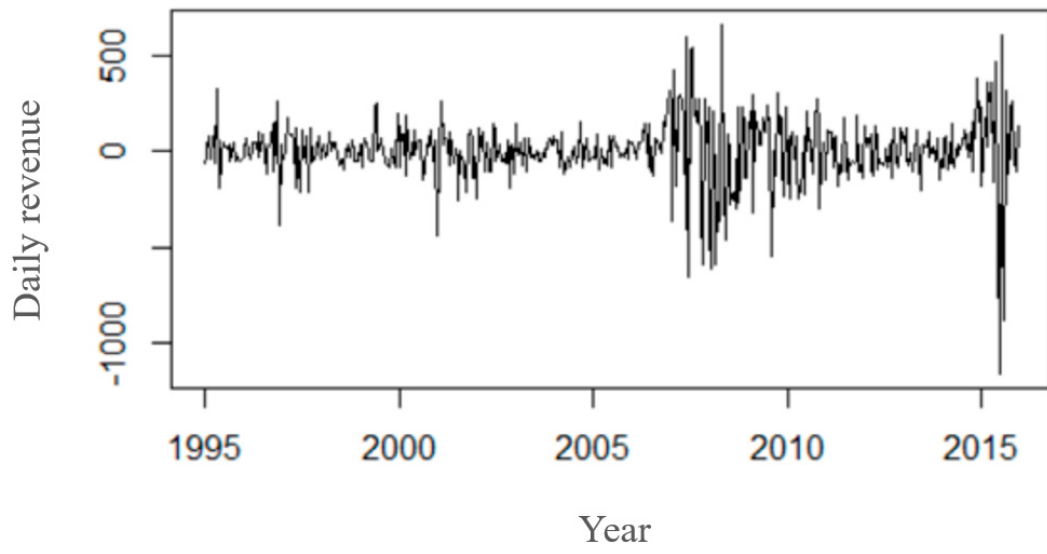
Figure 8. Result after the first-order difference of the Shanghai Index (daily revenue).